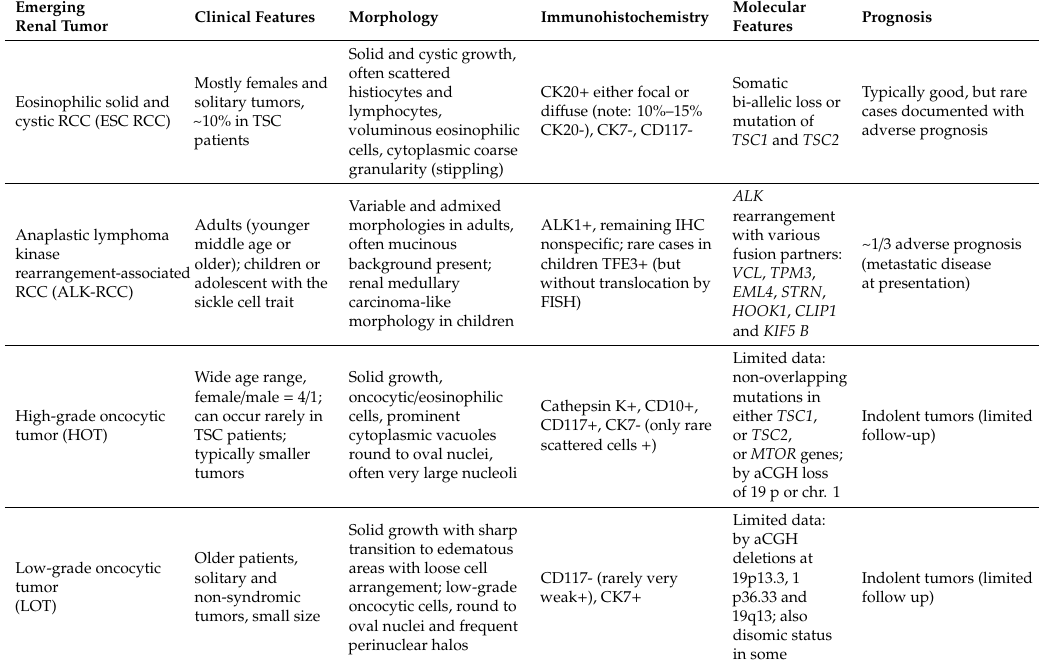
Table 1. Summary of the features of emerging renal tumors eosinophilic solid and cystic renal low-grade oncocytic renal tumor (LOT) and high-grade oncocytic renal tumor